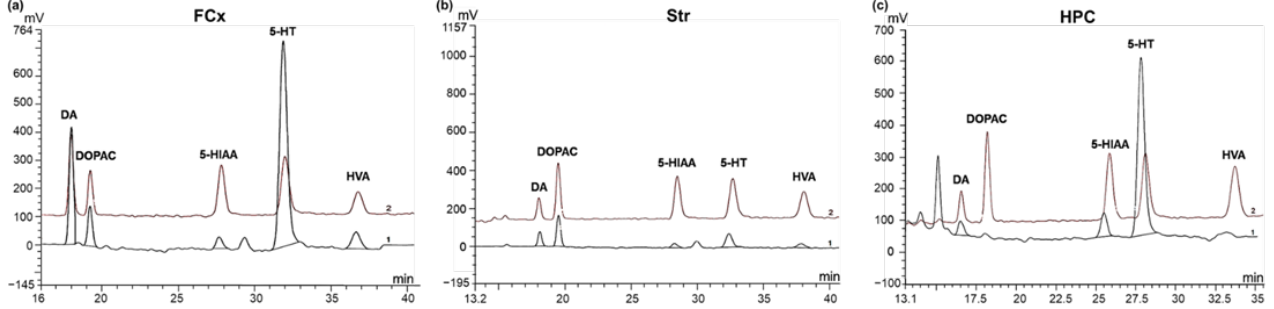
Figure 6. Representative chromatograms for the detection of dopamine (DA), 3,4-dihydroxyphenylacetic acid (DOPAC), homovanillic acid (HVA), serotonin (5-HT) and 5-hydroxyindolacetic acid (5-HIAA) by HPLC-EC. Signal overlay of one tested sample (1; black) and its corresponding standard solution (2; brown) in: ( a ) the Frontal Cortex (FCx); ( b ) the Striatum (Str) and; ( c ) the Hippocampus (HPC). Table 1. Effect of chronic oral administration of Safr’Inside TM (6.25 mg/Kg) on monoamines levels measured by HPLC in the FCx, Str and HPC.